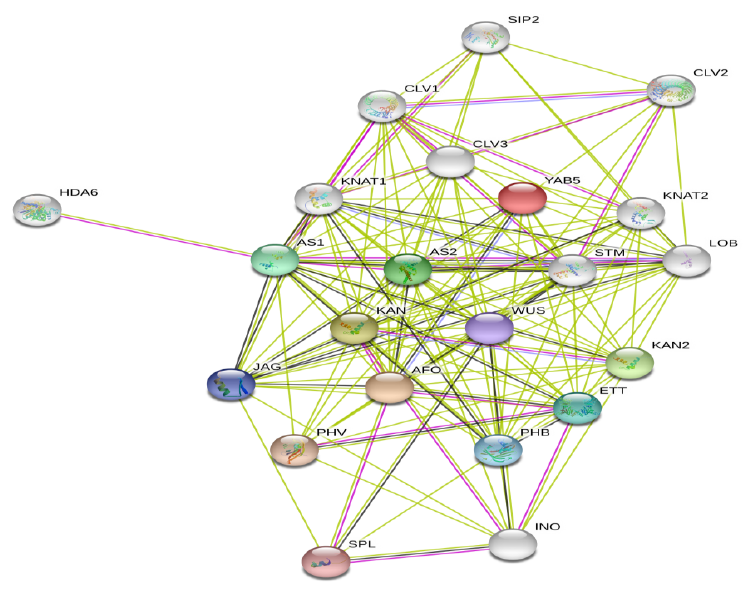
Figure 6. The prediction functional partners of AtYABBY-protein. Table 3. Putative proteins from di ff erent families interacted with